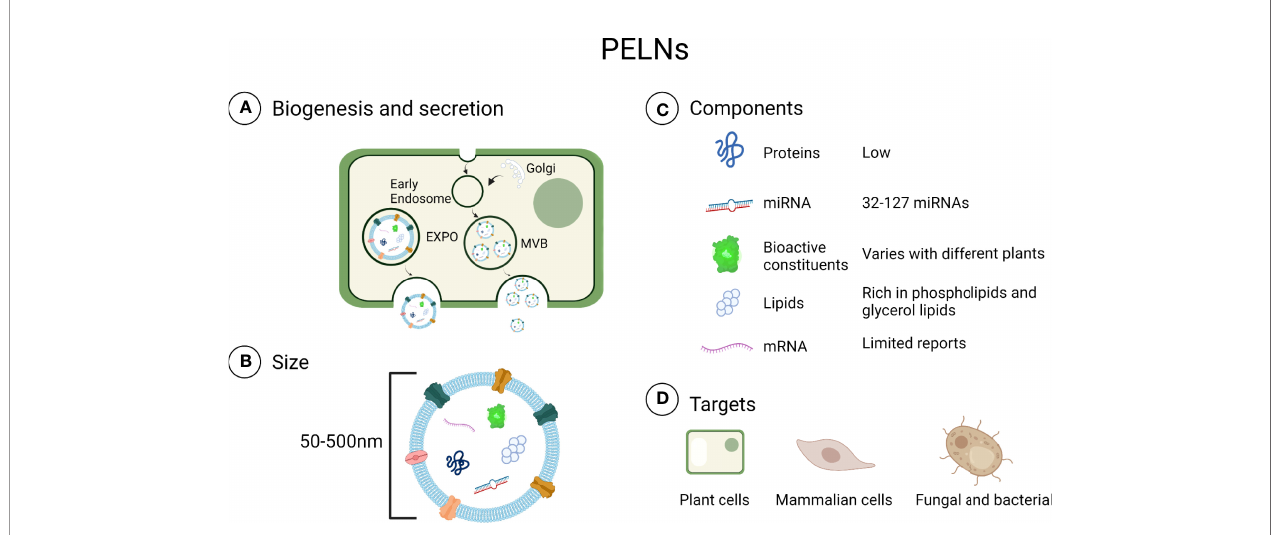
FIGURE 1 | Contents in PELNs. (A) Biogenesis and secretion: Plant cells can secrete PELNs via multivesicular bodies (MVB) and exocyst positive organelles (EXPO) (43, 44). (B) Size: PELNs range in size from 50 to 500 nm. (C) Components: Generally, PELNs contain fewer proteins and miRNAs than exosomes. (D) Targets: PELNs can be internalized in plant cells, mammalian cells, fungi, and bacteria (28, 45 – 47). Created with